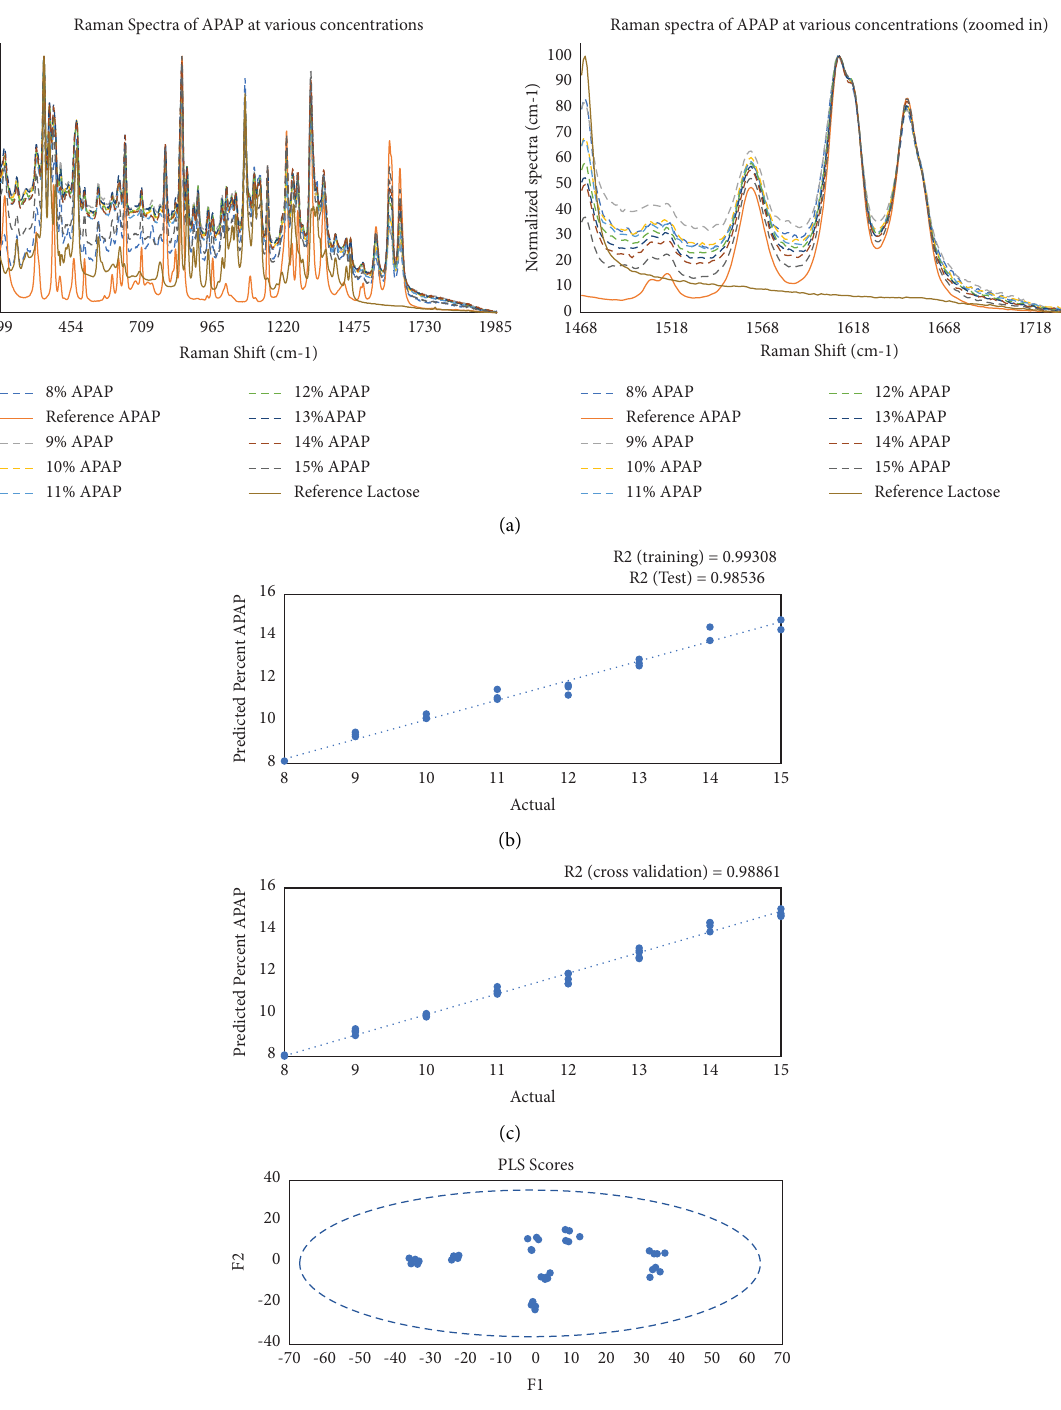
Figure 7: (a) Raman spectra of 8 blends and reference spectra of APAP in lactose, (b) predicted vs. actual training, (c) predicted vs. actual cross -validation, and (d) PLS